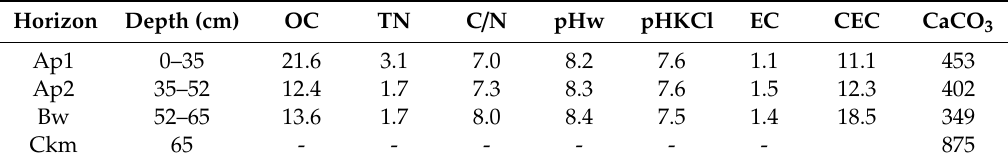
Table 1. Characteristics of the soil at the beginning of the experiment. Horizon